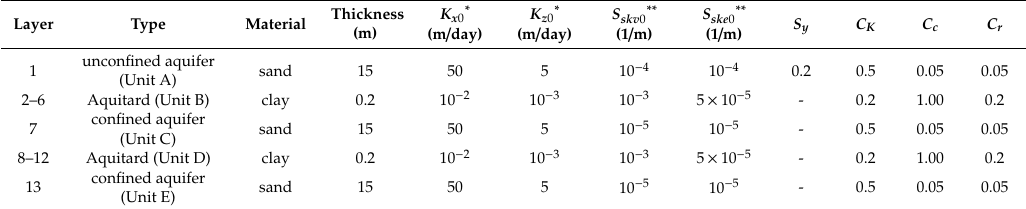
Table 2. Geostatic properties of the